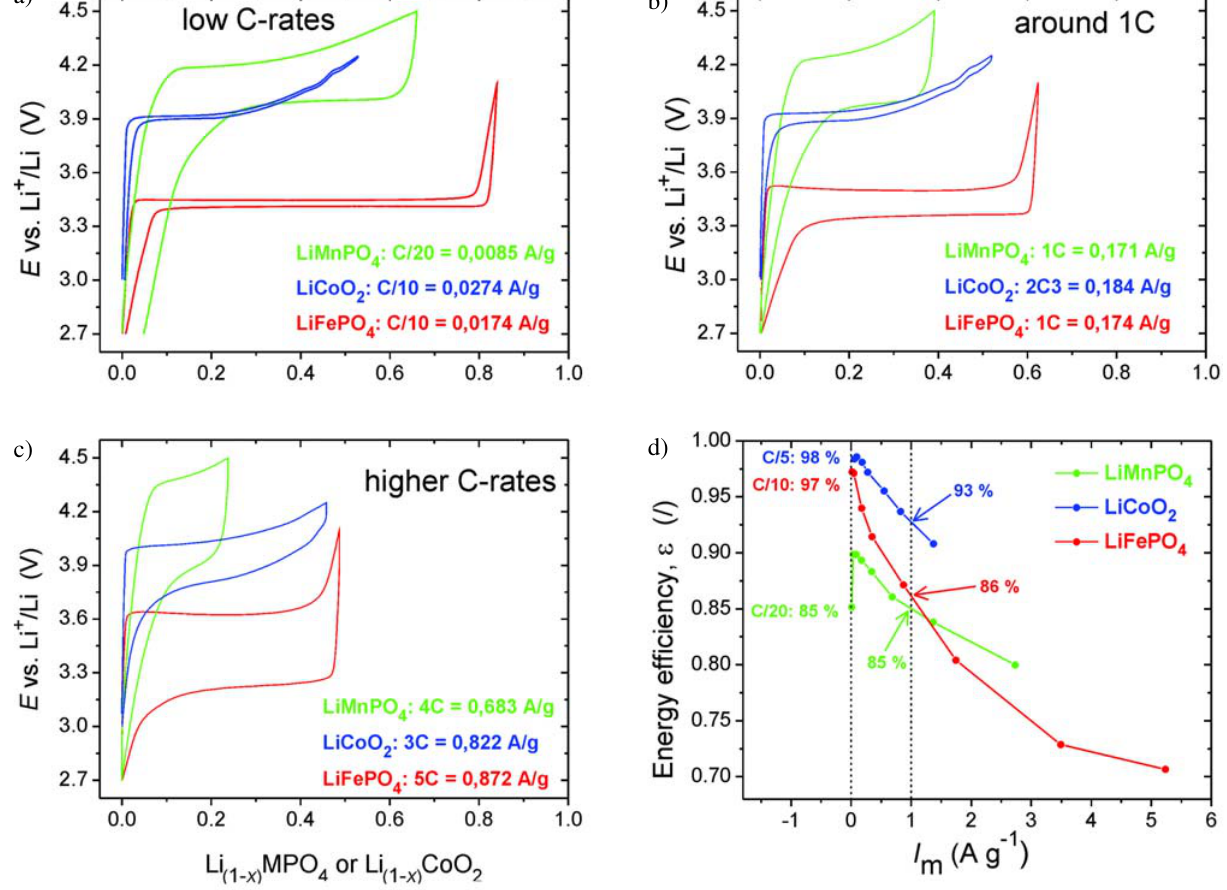
Figure 2. Direct comparison of the shape of selected galvanostatic cycles measured on LiFePO line) based electrodes at: a) low, b) medium, and c) higher current densities. The current densities shown are presented in terms of the normalized current, I . In all the cases the third cycle at the same C-rate is plotted. d) Energy efficiencies ( ε ) of the cells calculated using Equation (1) and plot- m ted versus normalized current, I m